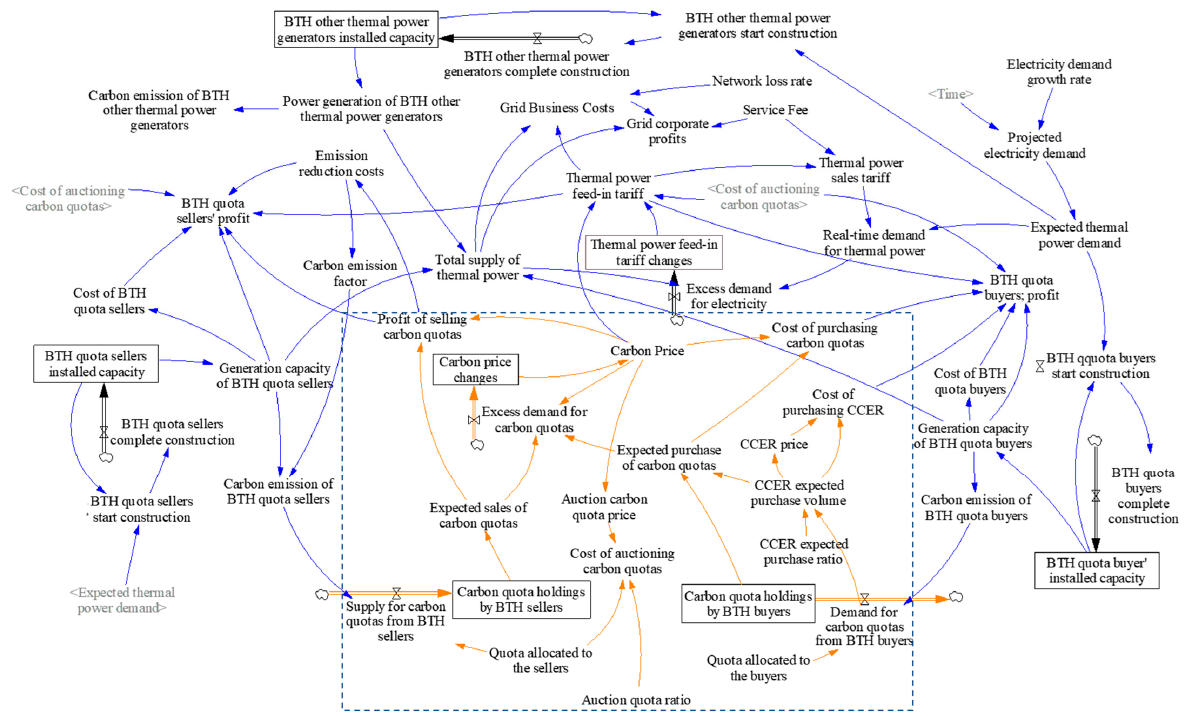
Figure 7. Interactive stock flow of carbon trading market and power market.